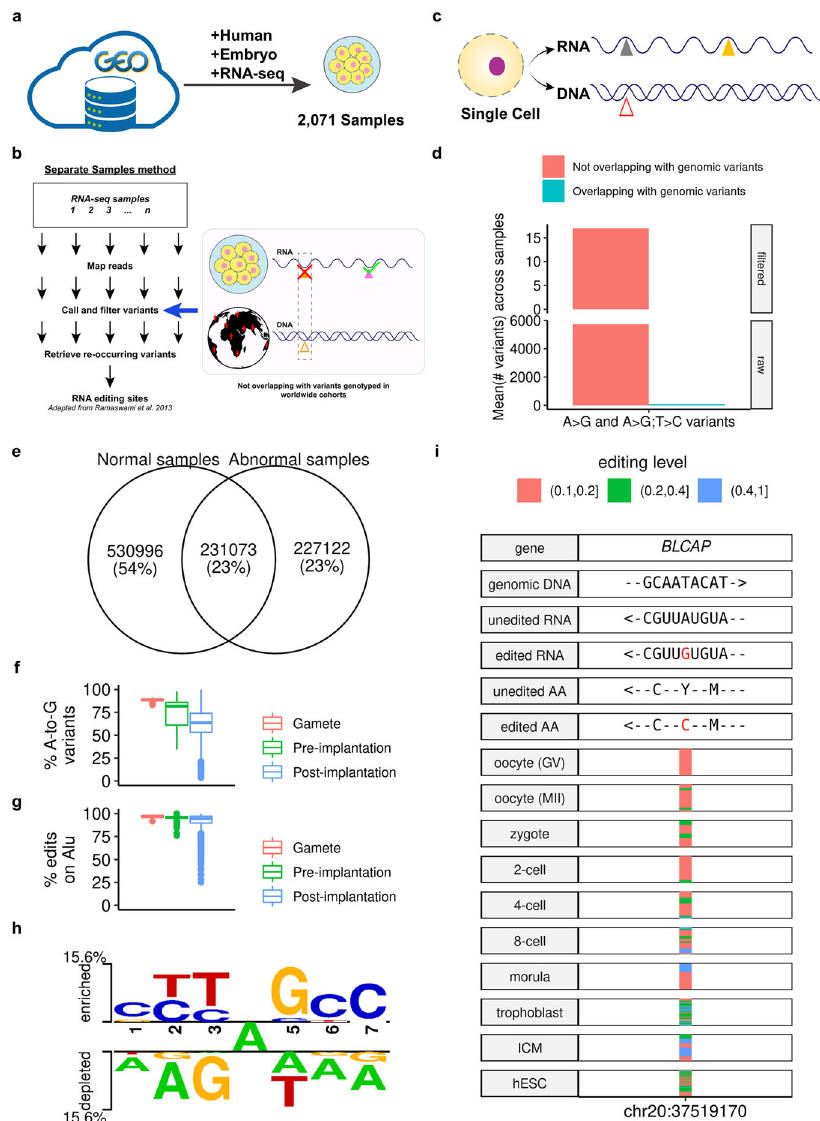
Fig. 1 Identi fi cation and validation of the A-to-I editome for human embryos. a Overview of RNA-seq curation from the public databases. b Overview of the adapted stringent pipeline. c , d The pipeline yielded a zero ratio of identi fi ed A-to-I RNA edits that overlapped with the DNA variants in the same cell across samples ( d ) in a paired DNA-RNA-sequencing dataset for single cells ( c ). The “ # ” denotes count. Also, see Supplementary Fig. 2 for the distribution of all possible types of nucleotide changes and the ADAR-binding motif derived from identi fi ed edits. e Total number of edits identi fi ed in all samples. The normal sites are those sites identi fi ed from 1797 normal, healthy samples, while the abnormal sites are those identi fi ed from 274 pathological samples (e.g., samples undergoing uniparental disomy (UPD) from Dataset GSE133854 38 ), or samples with non-control treatment (e.g., treated with amanitin as in Dataset GSE101571 85 ). Also, see Supplementary Figs. 10 – 12 for the comparison of the genomic distribution of normal and abnormal edits of the same stage. f A-to-G ratios for all variants detected across all samples. The proportion is de fi ned as the union of strand-de fi nite A-to-G variants and strand-ambiguous A-to-G/T-to-C variants (see Step (13) of Supplementary Note 1) to all variants. See also Supplementary Fig. 9 for this metric in Alu- and non-Alu-subsets. g Alu ratios for all edits across all samples. h The signature ADAR-binding motif computed from all edits. i The pro fi le of the BLCAP Y2C recoding edit across stages; the horizontal stripes represent edited samples with the color denoting the editing level. Arrows indicate the direction from the 5'- to the 3'- end (for DNA and RNA) or from the N-terminal to the C-terminal (for protein). Symbols in boxplots follow the de fi nition by “ geom_boxplot ” of the R package “ ggplot2 ” 96 : the inner thick line indicates the median; the lower and upper boundaries (or hinges) of the box indicate the fi rst and third quartiles (i.e., 25 and 75% quantiles), respectively; the upper whisker extends from the hinge to the largest value no further than 1.5 × inter-quartile range (the third quartile minus the fi rst quartile), the lower whisker extends from the hinge to the smallest value at most 1.5 × inter-quartile range of the hinge, and data beyond the end of the whiskers are the outlier points, which are plotted